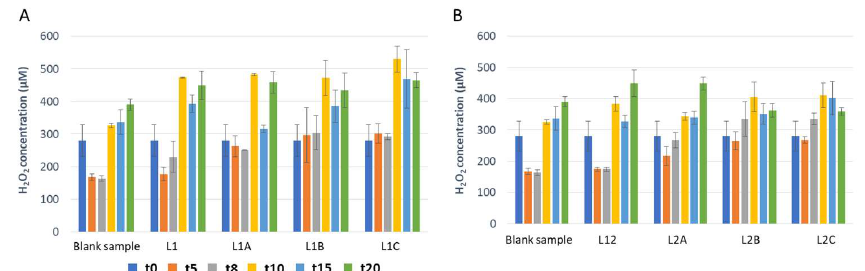
Figure 2. Hydrogen peroxide concentration examined in mozzarella samples contaminated with E. coli (k88, k99) over the shelf life. The covering liquid was inoculated with 2 Log CFU/mL ( A ) and 4 Log CFU/mL ( B ).